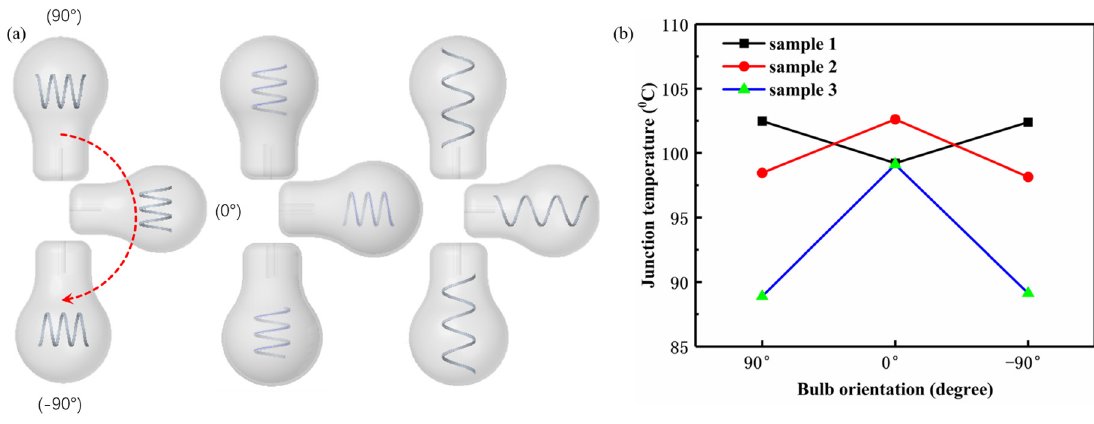
Figure 8. The junction temperature of LED filaments in various measuring orientations. ( a ) Measuring orientations of LED filament bulb; ( b ) Simulation results of three different filament bulbs.